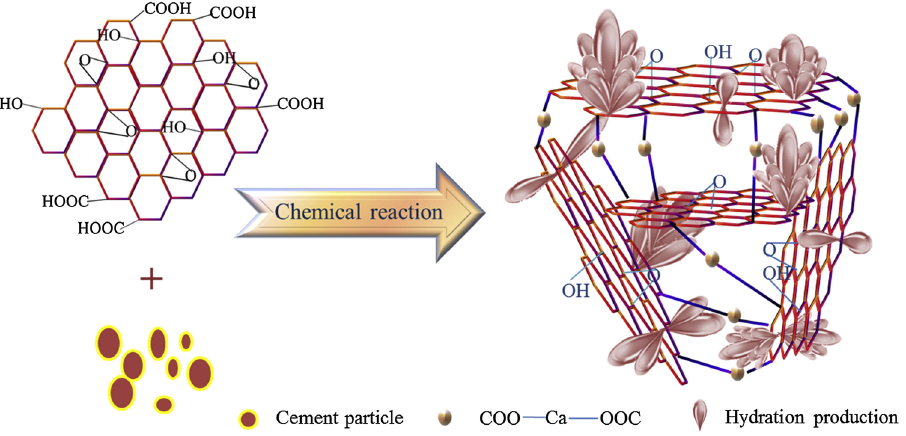
Figure 8: Schematic diagram of the mechanism of GO regulating hydration crystals proposed by Wang et al . [ 82 ]